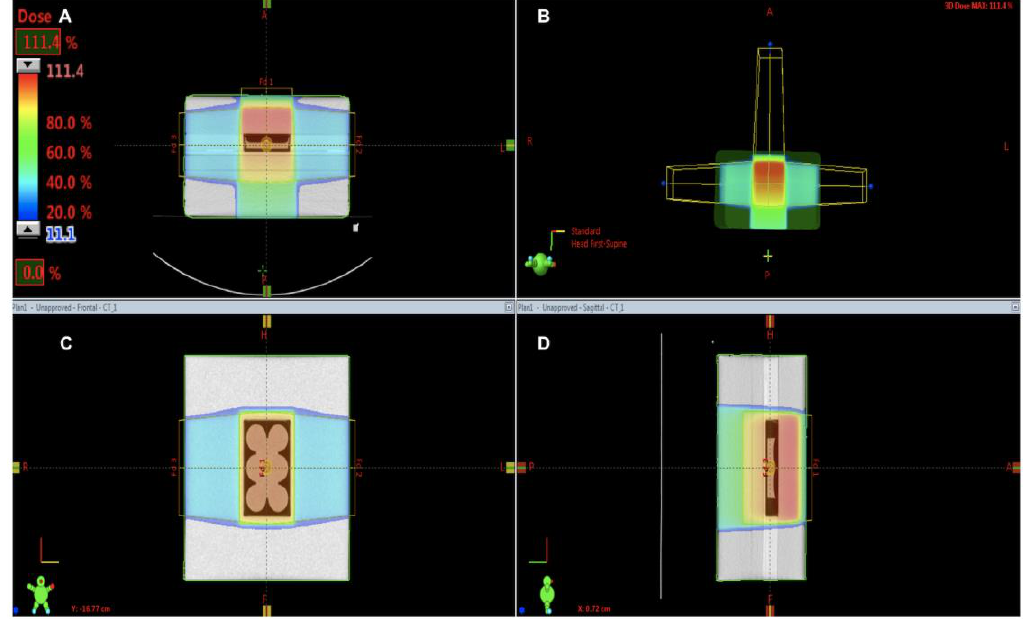
Figure 4. Irradiation setup. Demonstrates the dosimetry on the Eclipse ™ treatment planning system using a computed tomography (CT) simulation. ( A ) shows a sagittal view of the CT simulation of well plates. The well plates are within the 95% isodose line (orange), indicating that at least 95% of the prescribed dose is homogenously delivered to the GBM cells. ( B ) shows the 3-field technique (2 lateral opposed fields and a single anterior field). ( C ) is an axial view to demonstrate the field size encompasses all 4-well plates. ( D ) shows the lateral view of bolus and plastic